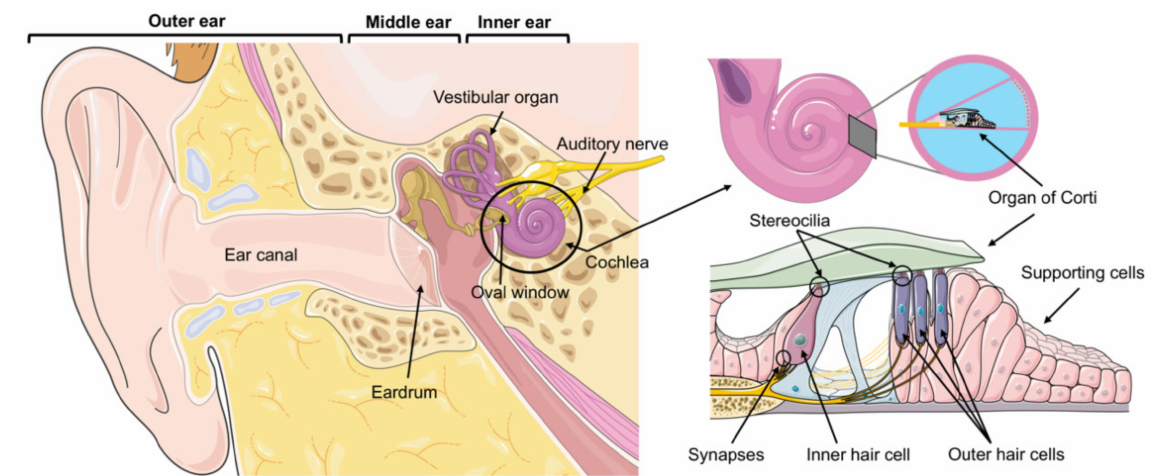
Figure 1. The anatomy of hearing. The spiral-shaped cochlea is the auditory sensory organ where mechanical sound waves are transmitted into electrical signals by the hair cells of the organ of Corti. See the text for further details. The figure was created with Servier Medical Art templates by Servier, which are licensed under a Creative Commons Attribution 3.0 Unported License; https://smart.servier.com (accessed on 16 January